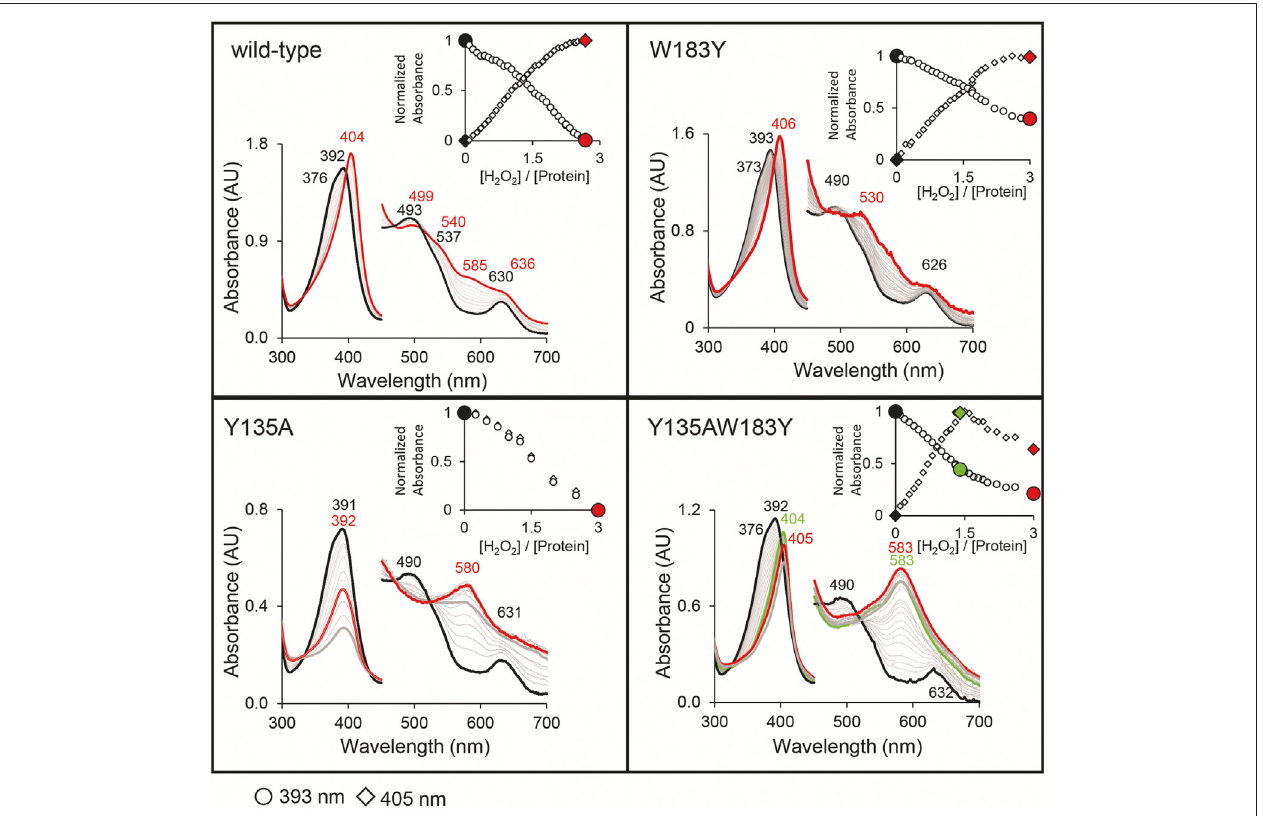
FIGURE 4 | Decarboxylase activity of wild-type Cd ChdC and variants Y135A, W183Y, and Y135AW183Y with hydrogen peroxide, followed by UV – Vis spectroscopy.Spectraltransitionfromthecoprohemeboundprotein(red)uponadditionofsub-equimolaramountsofH the coproheme Soret maximum ( ○ ) and the new maximum after the addition of three equivalents of hydrogen peroxide ( ◊ ).